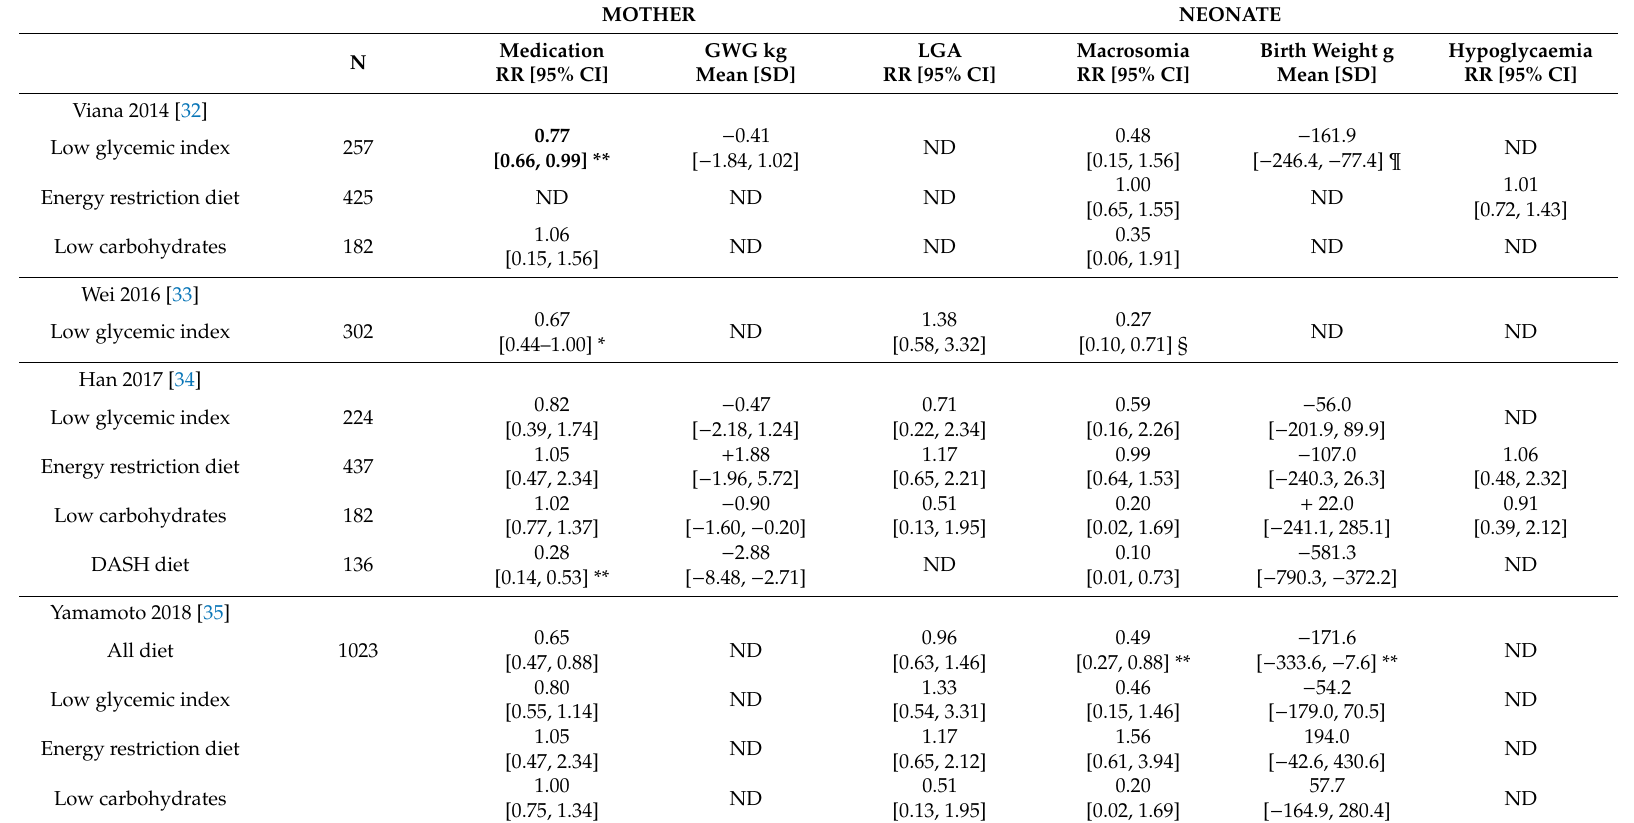
Table 3. E ff ect of diet advice interventions in women with gestational diabetes on the risk of maternal medication use, on gestational weight gain (GWG), on the growth at birth and on the risk of neonatal hypoglycaemia according to meta-analyses. Values are in bold when the results were statistically significant; p values are indicated when they were reported in the reviews. LGA: Large for Gestational